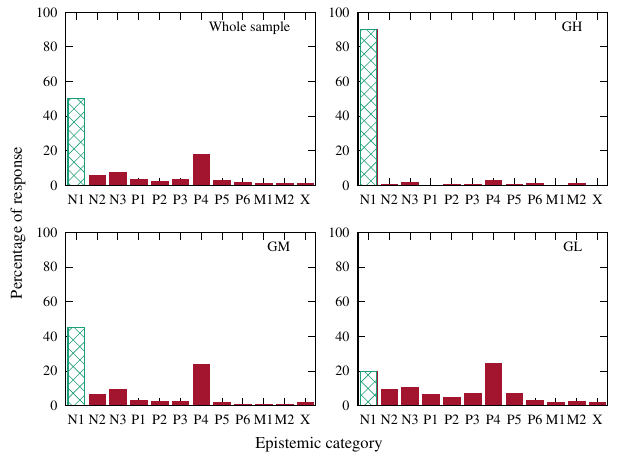
FIG. 4. Aggregate distribution of responses to all propositions (S5, S7, S8, S9, S13, S17, S19) corresponding to epistemic category N1. The percentage distributions for the whole sample, as well as the three groups, GH, GM, and GL are shown. The total for each subsample is normalized to 100%. The correct response is marked with the hashed green pattern while other responses are marked in solid red. The case of no responses is shown as